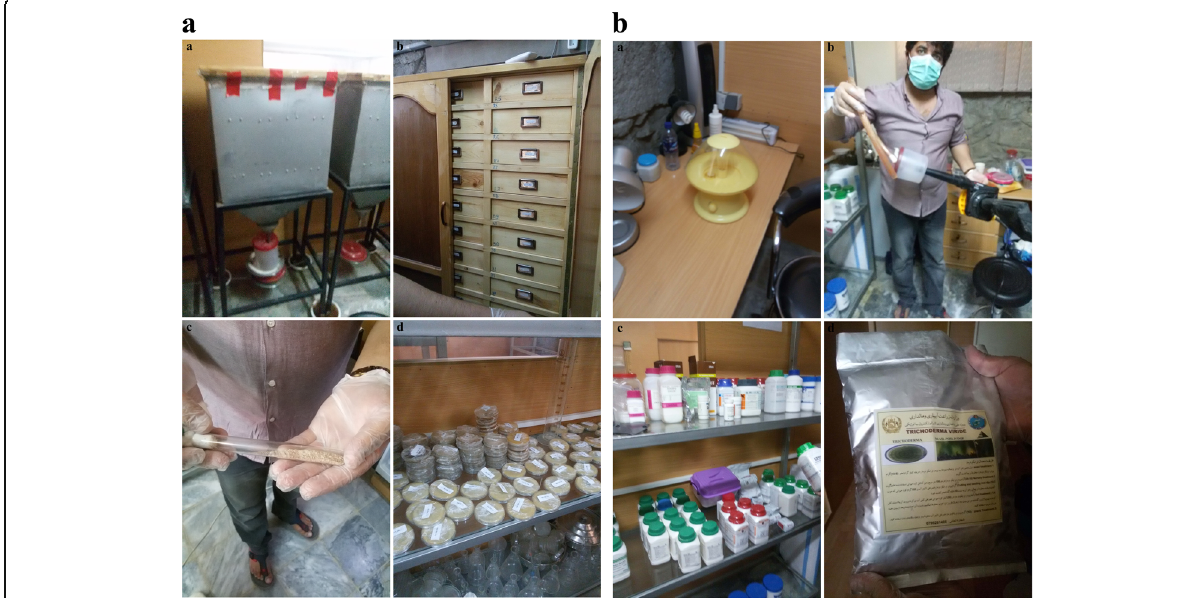
Fig. 2 Mass production facilities for parasitoids and microbial agent as biocontrol agents in